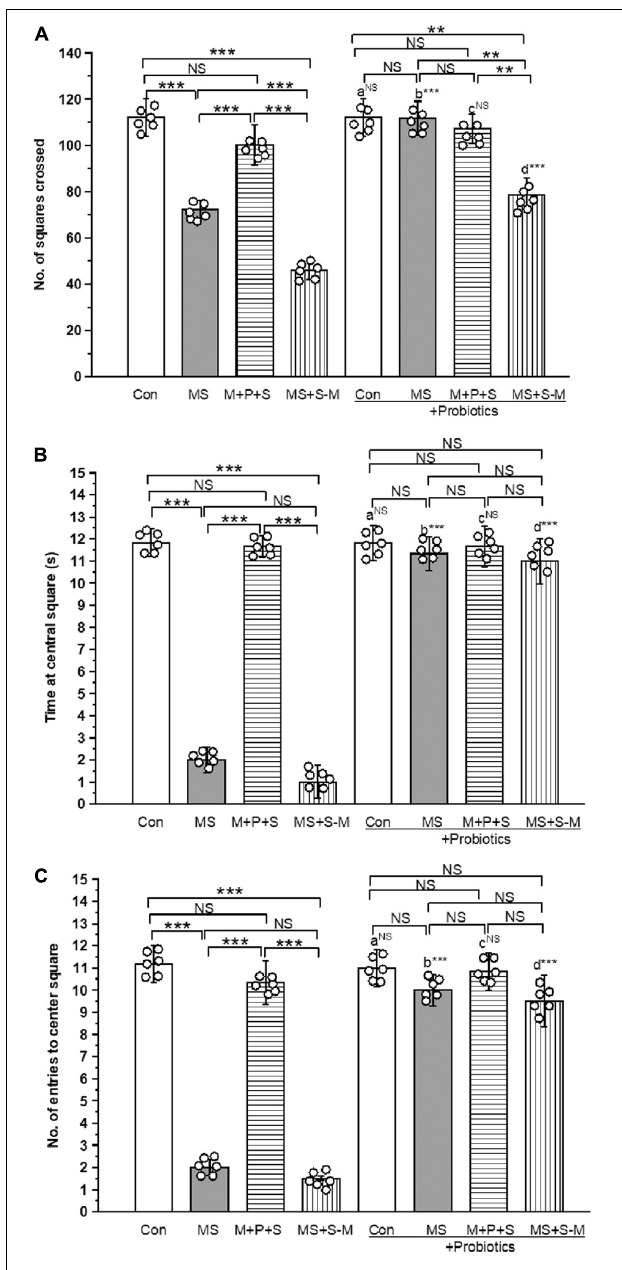
FIGURE 3 | The open field test indicates that Lactobacillus supplementation prevented anxiety-like behavior induced by early life SSE. In the open-field test, the Lactobacillus supplemented group significantly crossed more squares (A) , spent more time at central square (B) , higher numbers of entries to the center square (C) . Values are presented as mean ± SEM. Significant differences between groups are indicated by *** P < 0.001, ** P < 0.01; a: con vs. con + Pro; b: MS vs. MS + Pro; c: M + P + S vs. M + P + S + Pro; d: MS+S–M vs. MS+S–M + Pro; NS, not significant.